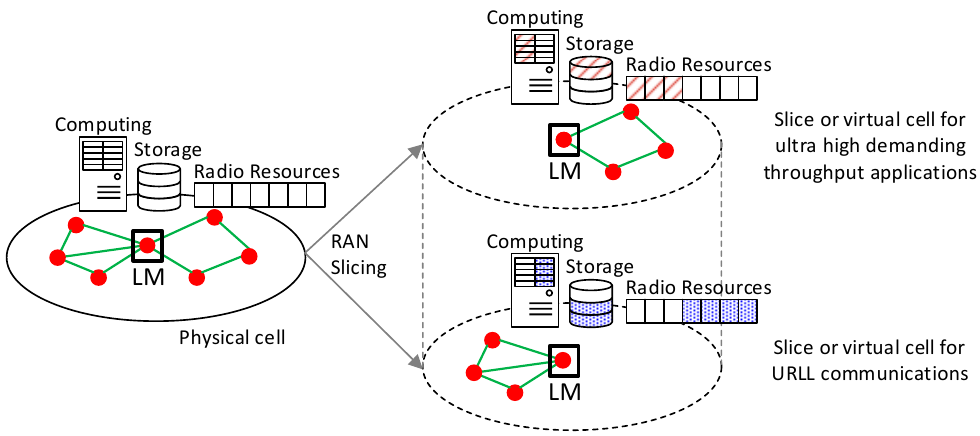
Figure 7. Virtual cells based on Radio Access Network (RAN) Slicing.